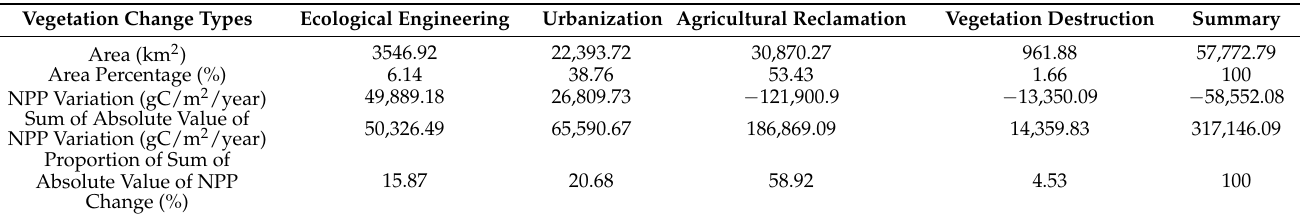
Table 5. 2015–1982 NPP variation of all pixels and the absolute value of its proportion under the changed vegetation